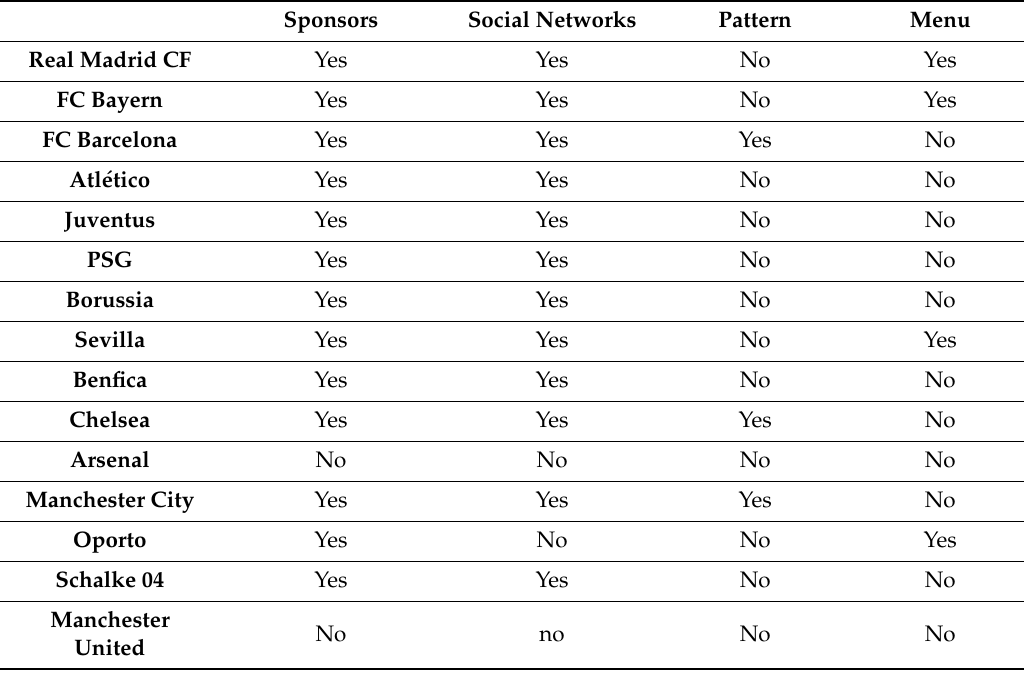
Table 7. Design of the bottom